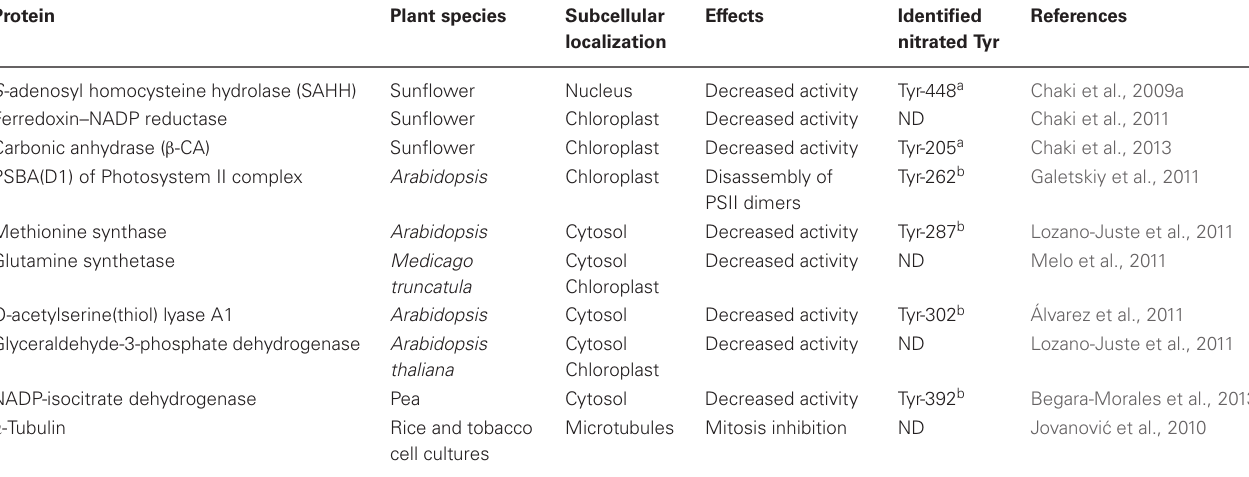
Table 1 | Examples of proteins identified in higher plants which are targets of tyrosine nitration, and the effect of this PTM on their function.